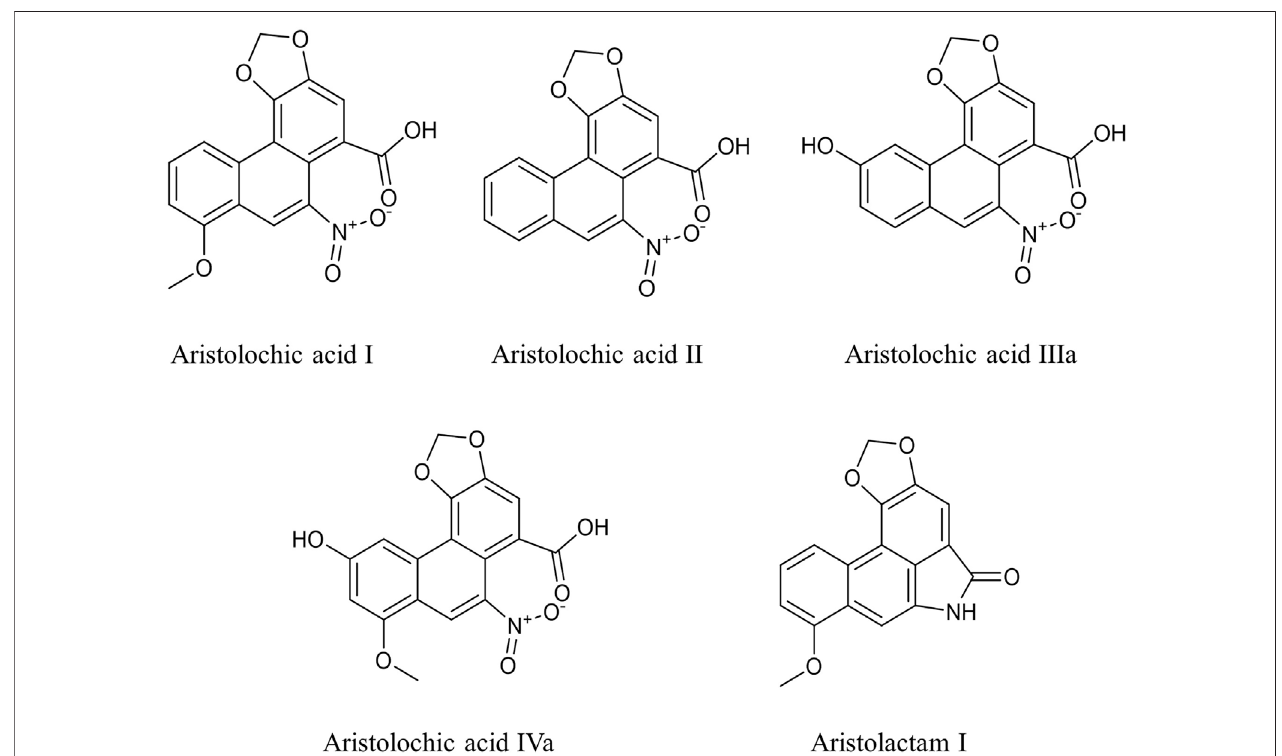
FIGURE 1 | Chemical structures of aristolochic acid analogues in this study.